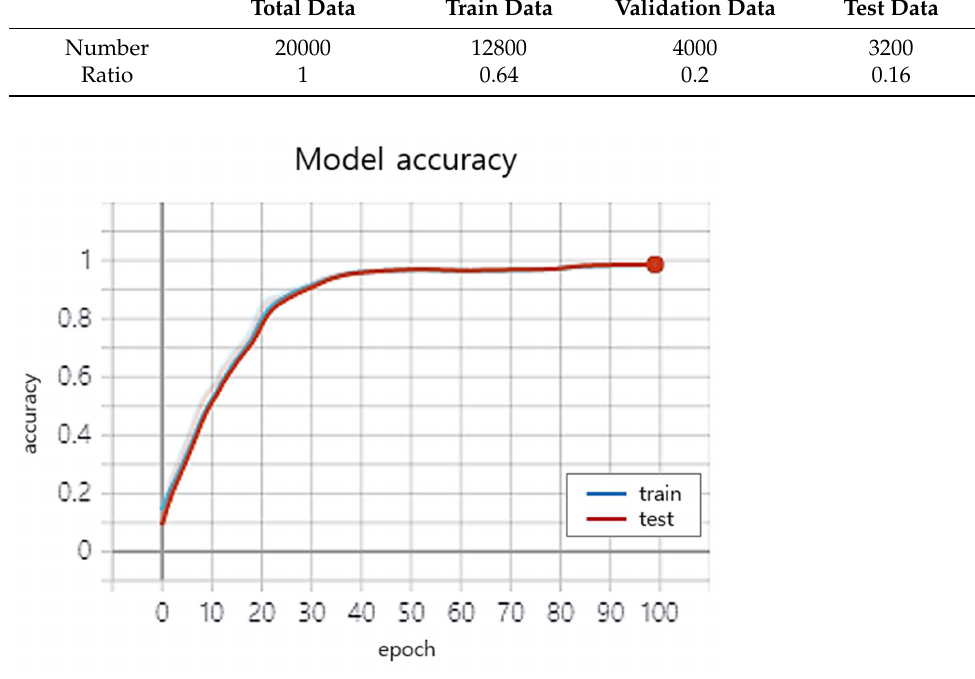
Information 2021 , 12 , x FOR PEER REVIEW Figure 8. Training and test accuracy graphs for deep learning models. Figure 8. Training and test accuracy graphs for deep learning models.